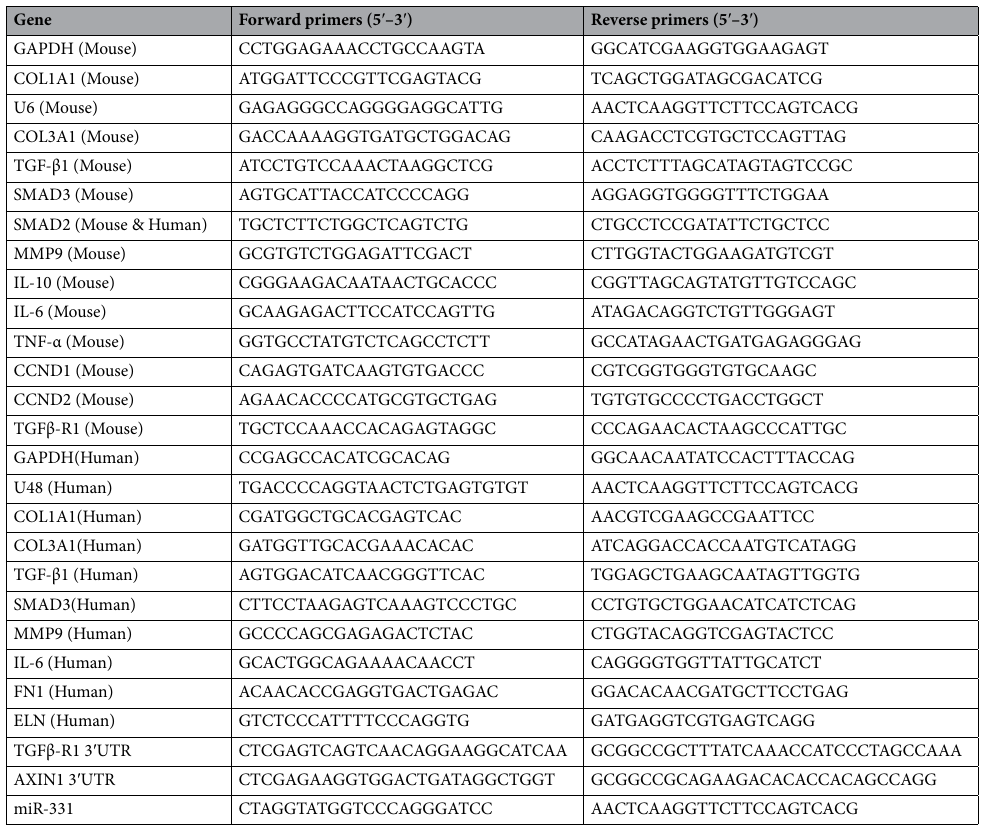
Table1. List of the real time PCR